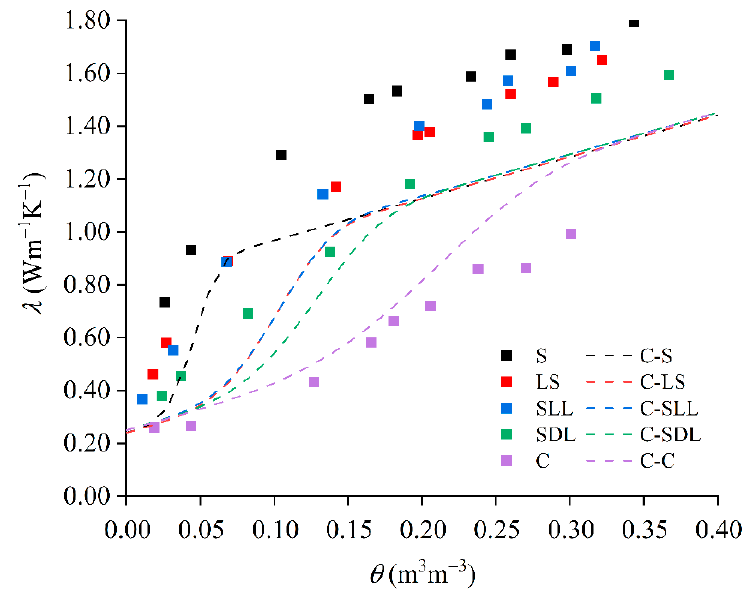
Figure 1. The measured relationship of λ ~ θ and the curves estimated by the Campbell model for soil with different textures. The colored dots represent the measured values and the dotted lines represent the Campbell model curves.